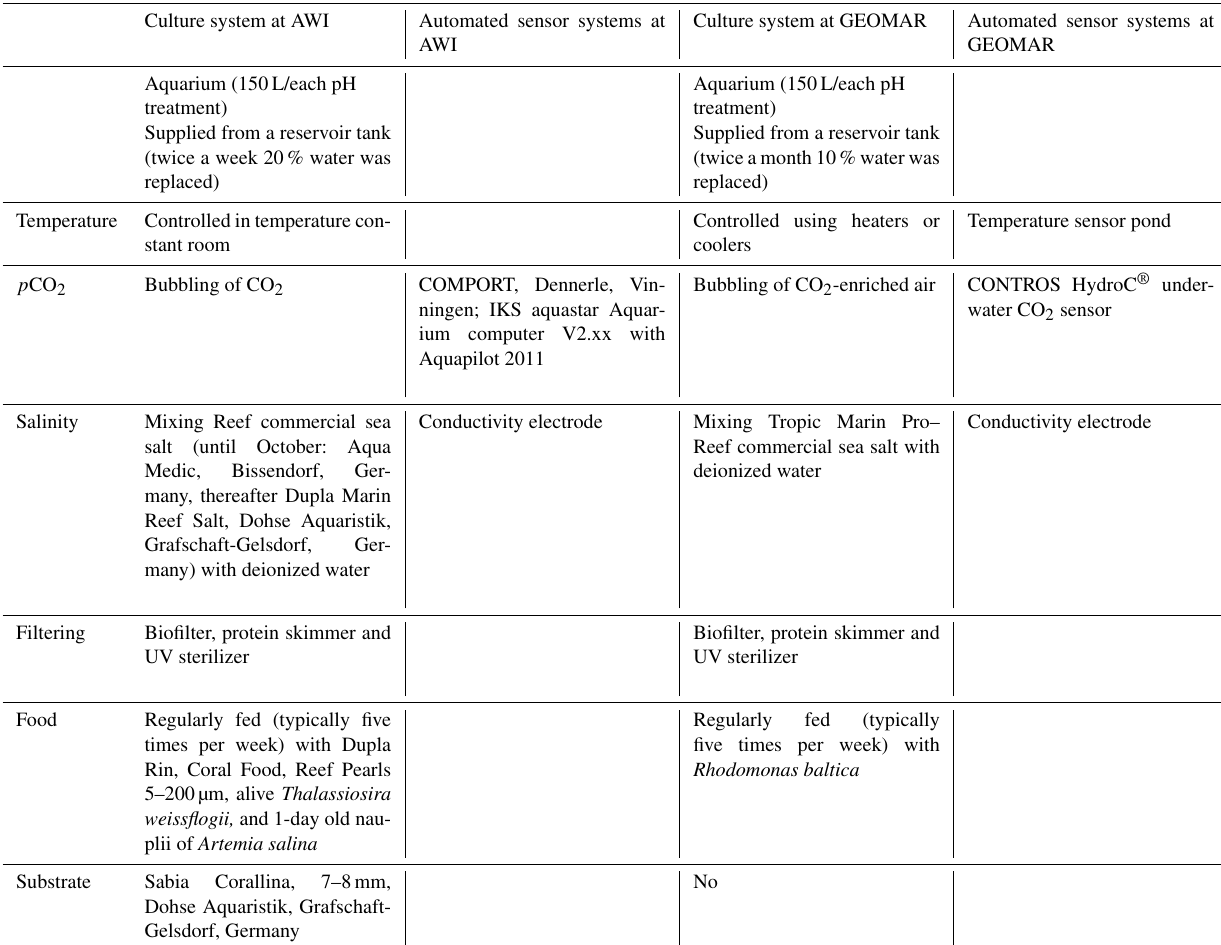
Table 2. Culture and sensor systems used in M. venosa culturing (specimens: no. 43, no. 63, no. 8004, no. 8005, no. 9004, no. 9005 and no. 9006). Operated under controlled experimental settings in climate-controlled laboratories at Alfred-Wegener-Institut Helmholtz-Zentrum für Polar- und Meeresforschung, Bremerhaven, Germany, and at GEOMAR Helmholtz-Zentrum für Ozeanforschung Kiel,